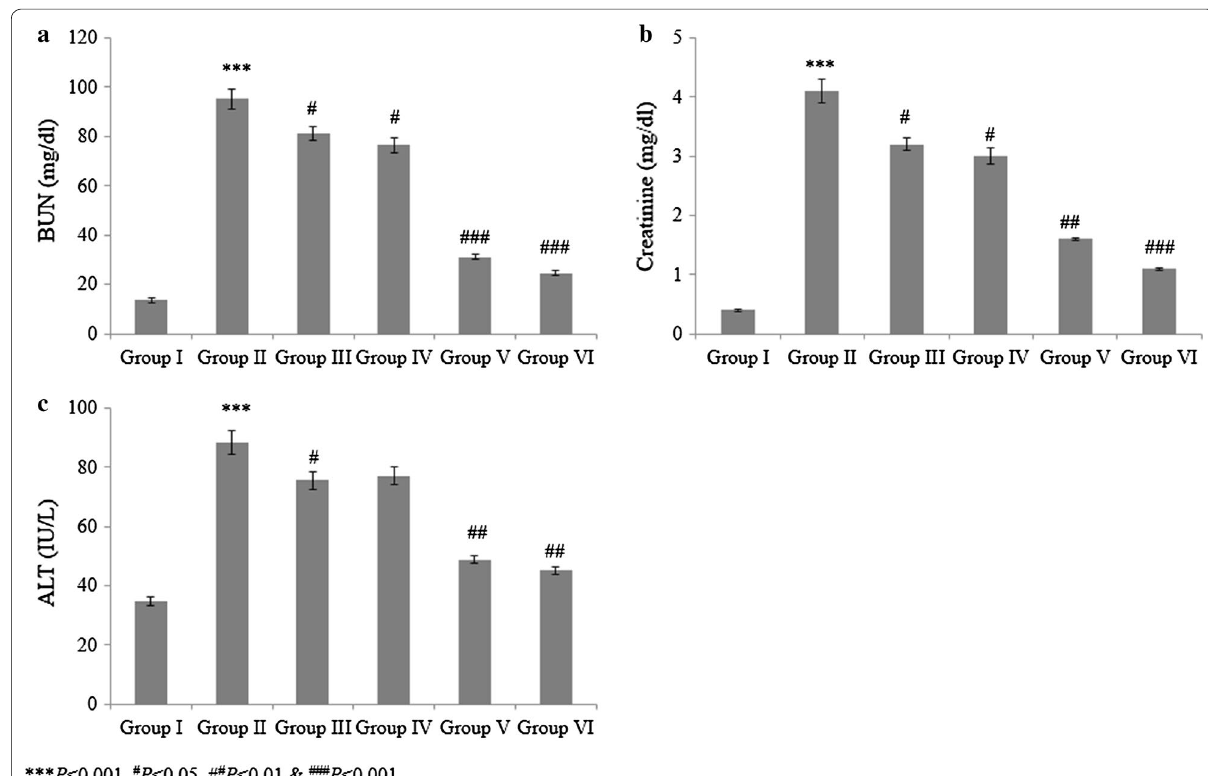
Fig. 1 Effects of erythropoietin and sesame oil on a blood urea nitrogen (BUN), b creatinine, and c alanine aminotransferase (ALT) levels in rats with ischemic kidney injury after kidney transplantation. *** P < 0.001 vs. sham rats; # P < 0.05, ## P < 0.01, and ### P < 0.001 vs. control